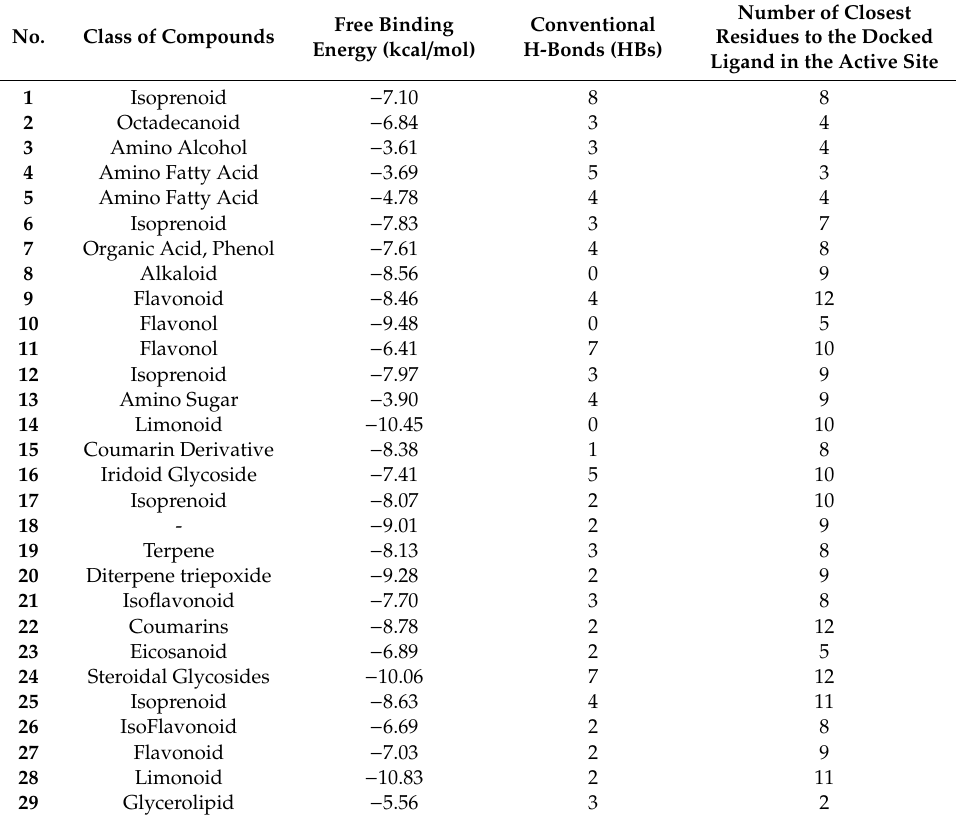
Table 6. Docking binding energies, conventional hydrogen bonding, and the number of closest residues to the docked compounds into the active site of the human